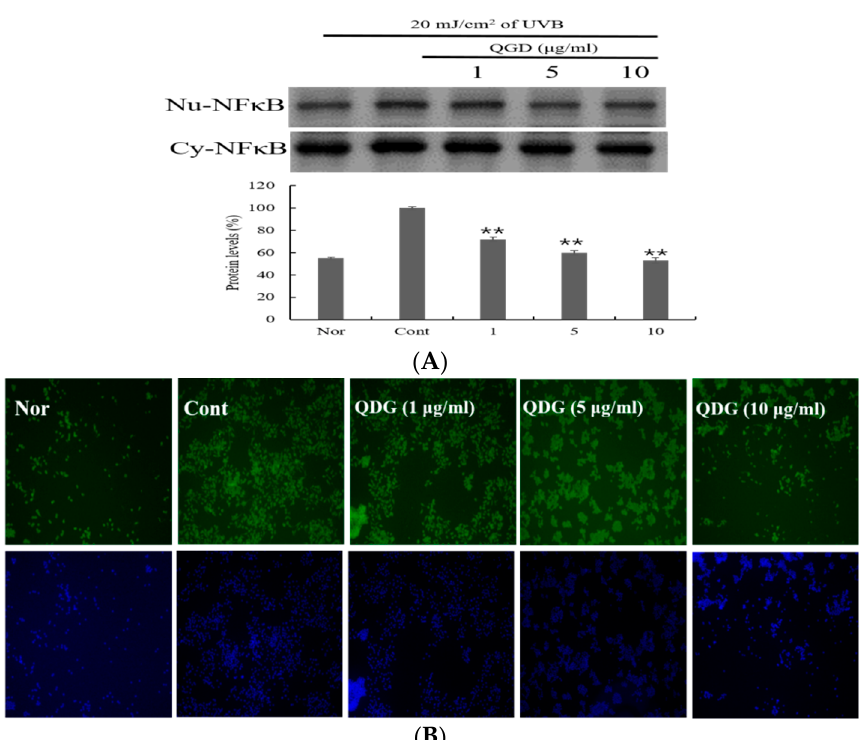
Figure 6. Effect of QDG treatment on NF- κ B protein expression in HaCaT cells. HaCaT cells were treated with different concentrations of QDG (1, 5, and 10 µ g/mL) after irradiation with 20 mJ/cm 2 UVB. After 6 h, cells were harvested, and ( A ) protein and ( B ) NF- κ B–FITC levels were determined. Histogram shows the densitometry of NF- κ B protein normalized to glyceraldehyde 3-phosphate dehydrogenase. Each value represents mean ± SD for the three individual experiments. Nor: No treatment group (0 h), Cont: 20 mJ/cm 2 UVB treatment group, QDG = QDG treatment group. n = 3, * = p < 0.001 and ** = p < 0.0001 compared with the control group.